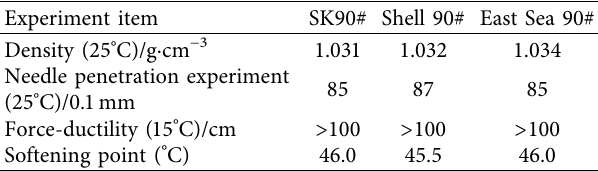
Table 1: Main technical indexes of base asphalt.